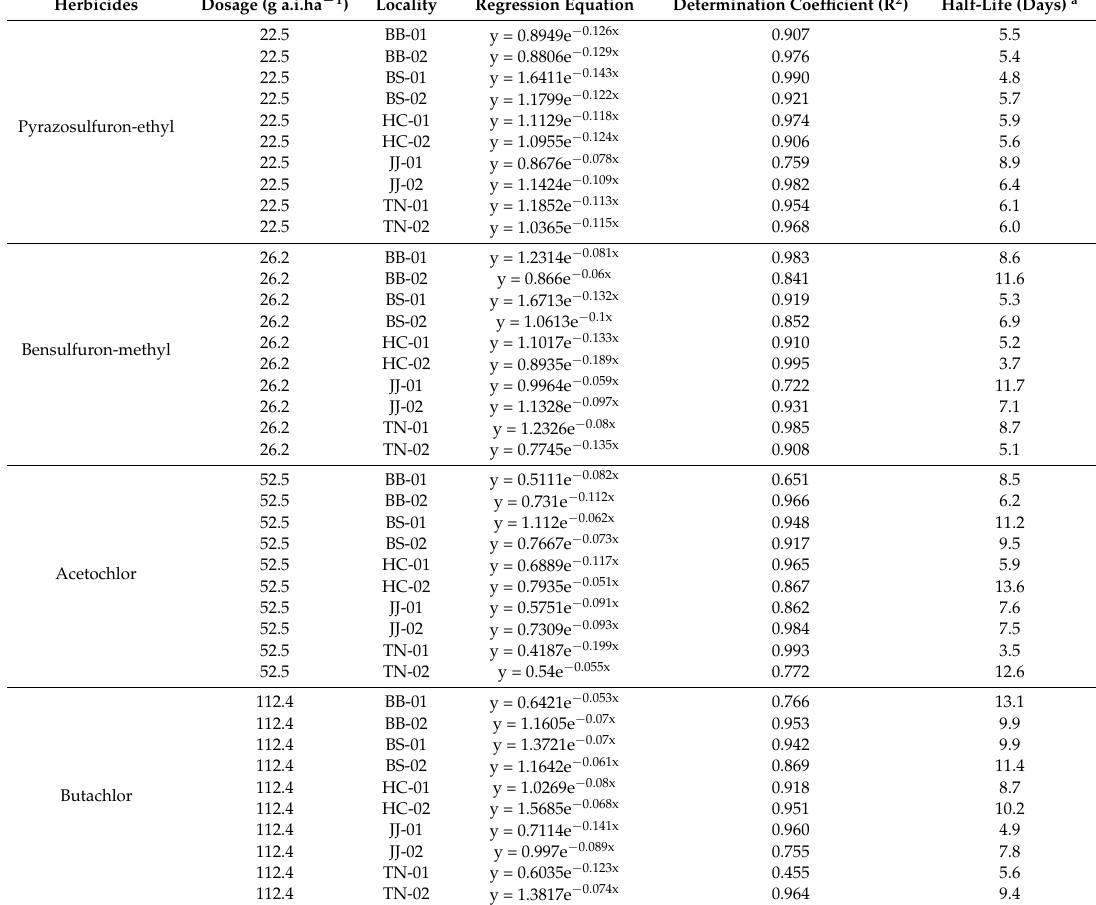
Table 5. The dissipation half-lives of four herbicides in rice soil (low-dosage). Herbicides Dosage (g a.i.ha − 1 ) Locality Regression Equation Determination Coefficient (R 2 )